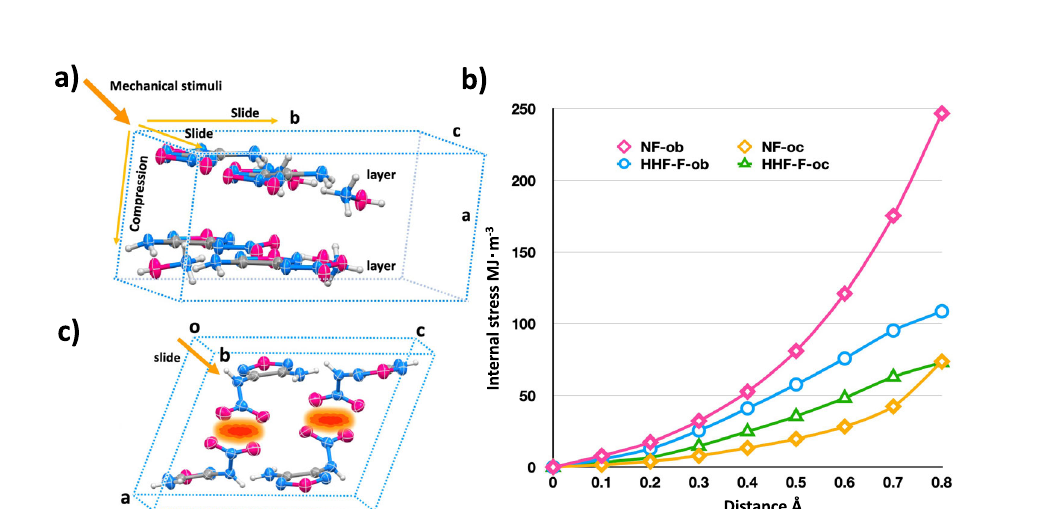
Fig. 7 | Analysis ofenergy changes before and after molecular deformation for HHF-F and NF. a Model for external forces acting on HHF-F crystal unit cell. b Internal stress curve along the b and c axes for HHF-F (HHF-F-ob and HHF-f-oc)